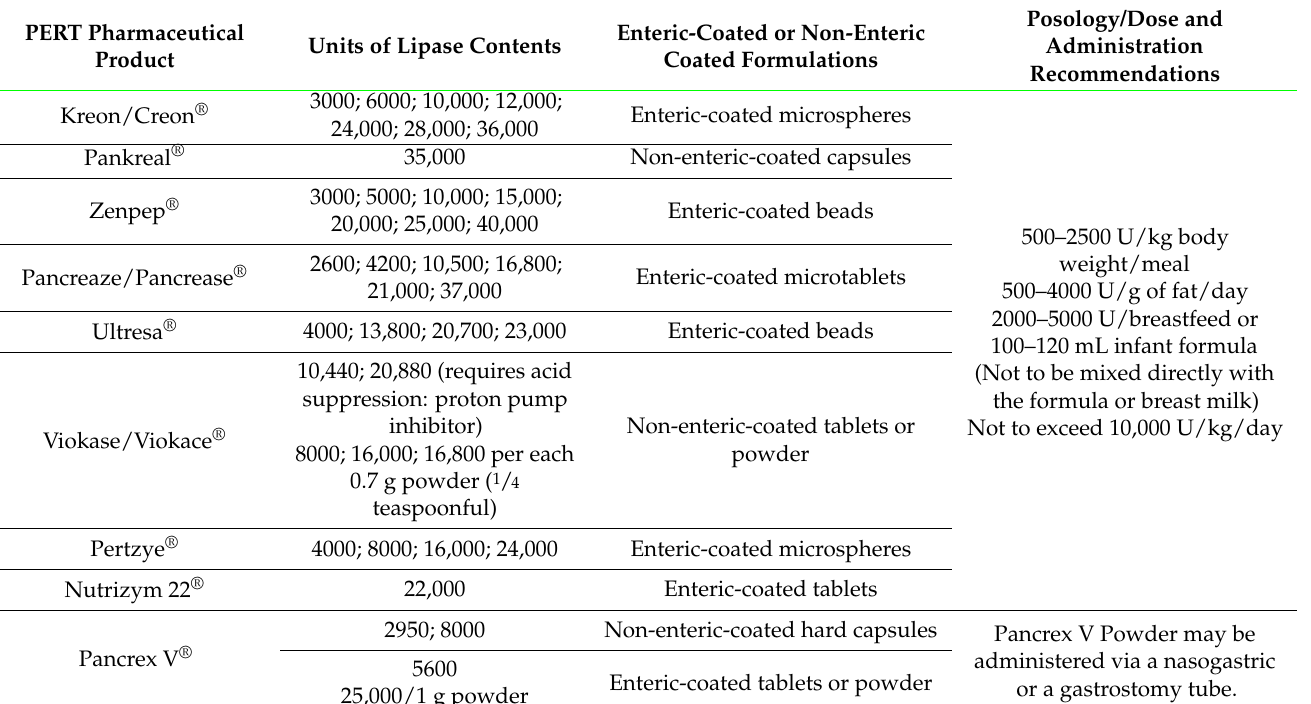
Table 1. Pancreatic Enzymes Replacement Therapy (PERT) in children: Marketed pharmaceutical products, the lipase units’ contents and dose recommendations